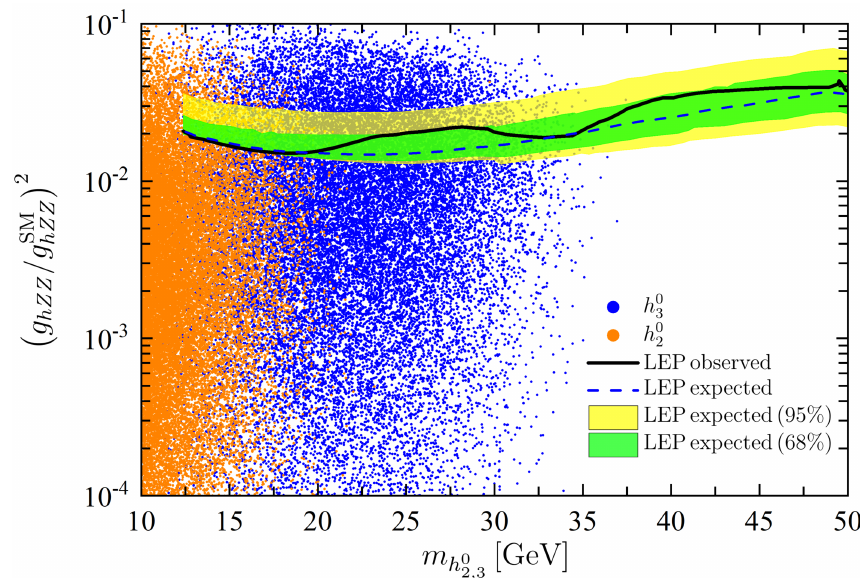
) 2 at 95% confidence level, for m ≥ 10 GeV, h 0 2 , 3 hZZ and m vs. vs ( g ) 2 points, for the considered SM hZZ /g h 0 2 h 0 3 hZZ